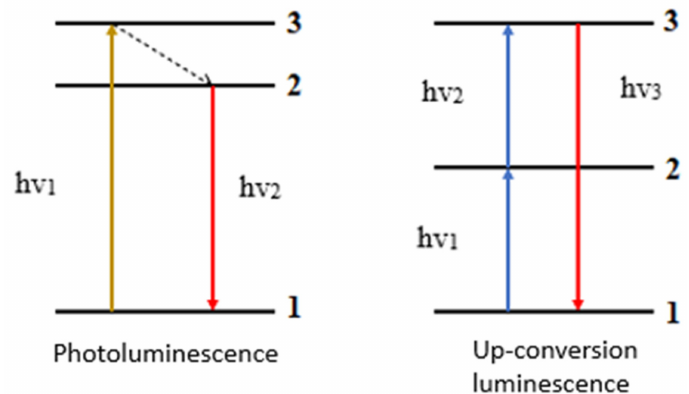
Figure 2. Schematic representation of the processes of classical luminescence and upconversion